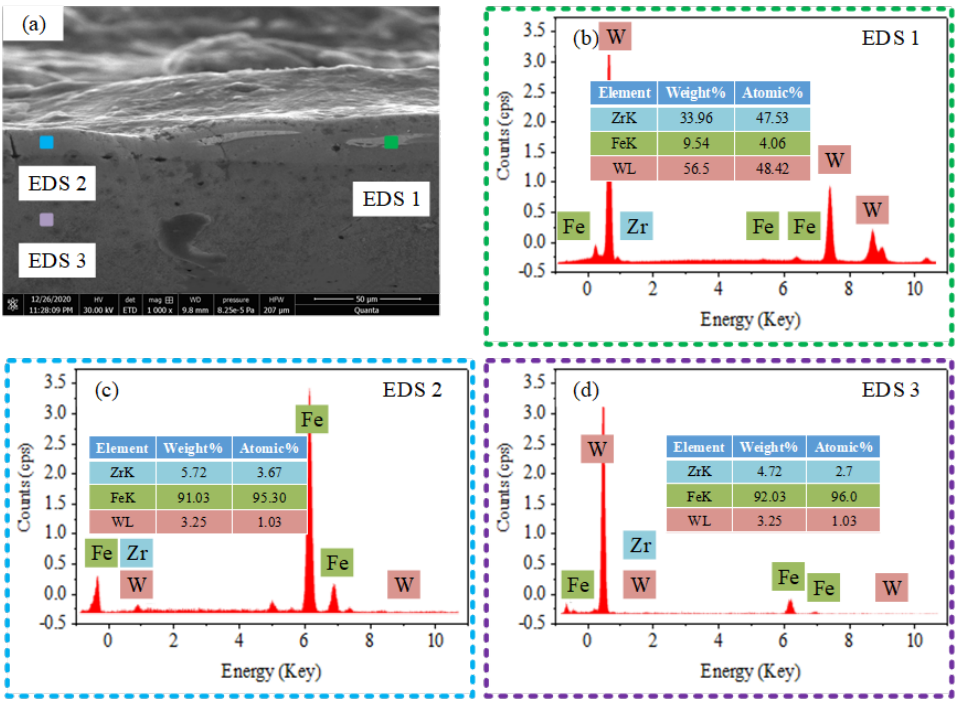
Figure 8. Section morphology and EDS spectra of the crater. ( a ) Region II of Wf/Zr-MG crater, ( b ) EDS 1, ( c ) EDS 2, and ( d ) EDS 3.